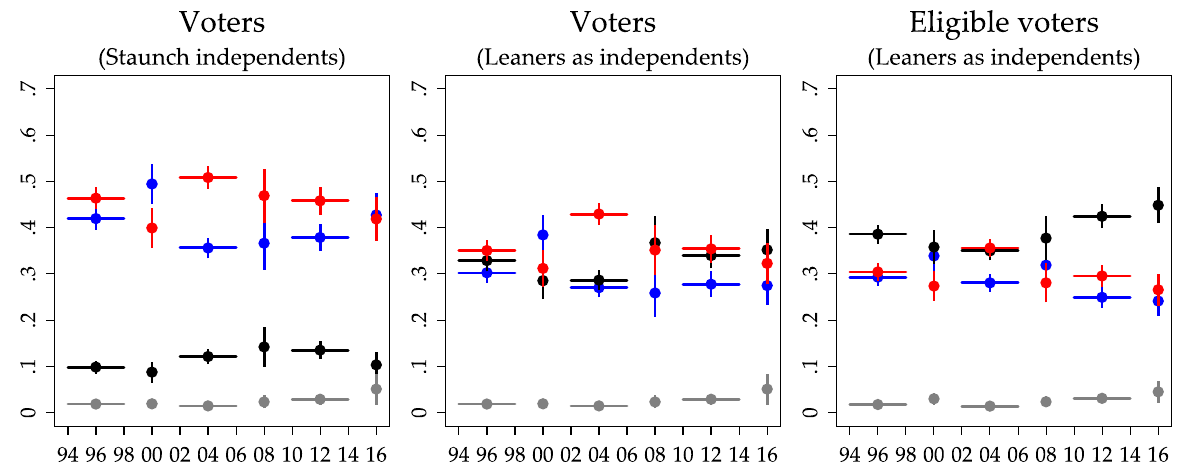
Figure 9: Class IVab trends in identification with the Democratic Party (blue), Republican Party (red), another party (gray), and independent